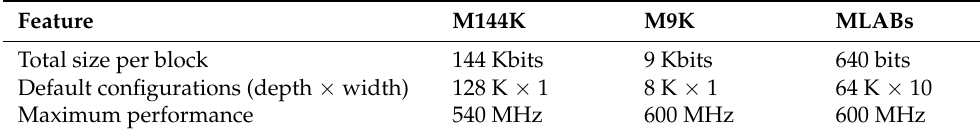
Table 5. On-Chip memory blocks on Stratix IV family.